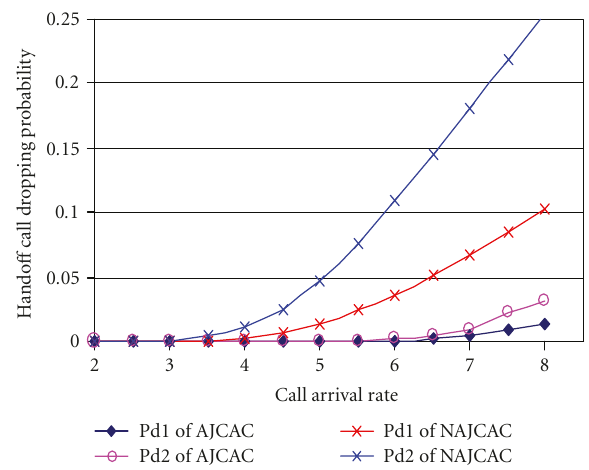
Figure 6: E ff ect of varying the call arrival rate on the hando ff call dropping